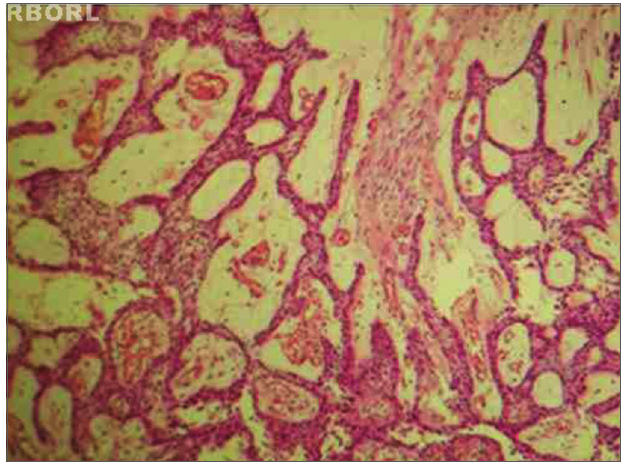
Figura 2. Ameloblastoma padrão plexiforme mostrando estroma com degeneração tipo cístico. HE